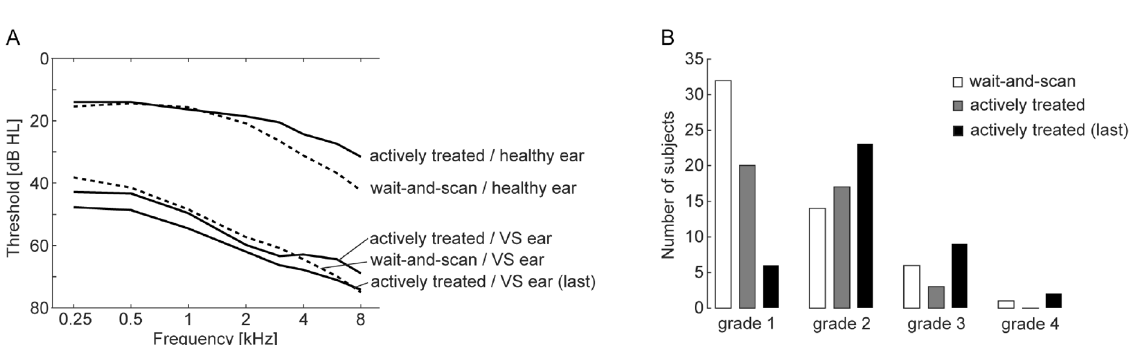
Figure 2. Diagnostic data of the patients included in the analysis. The bars represent the number of subjects having a certain characteristic. N/A not available; n ABR/DPOAE response not present; p ABR/DPOAE response present; r ABR with signs of retrocochlear lesion; l ABR with prolonged latencies. Yes + annoying tinnitus. Gray bars—actively treated patients; white bars—wait-and-scan patients.